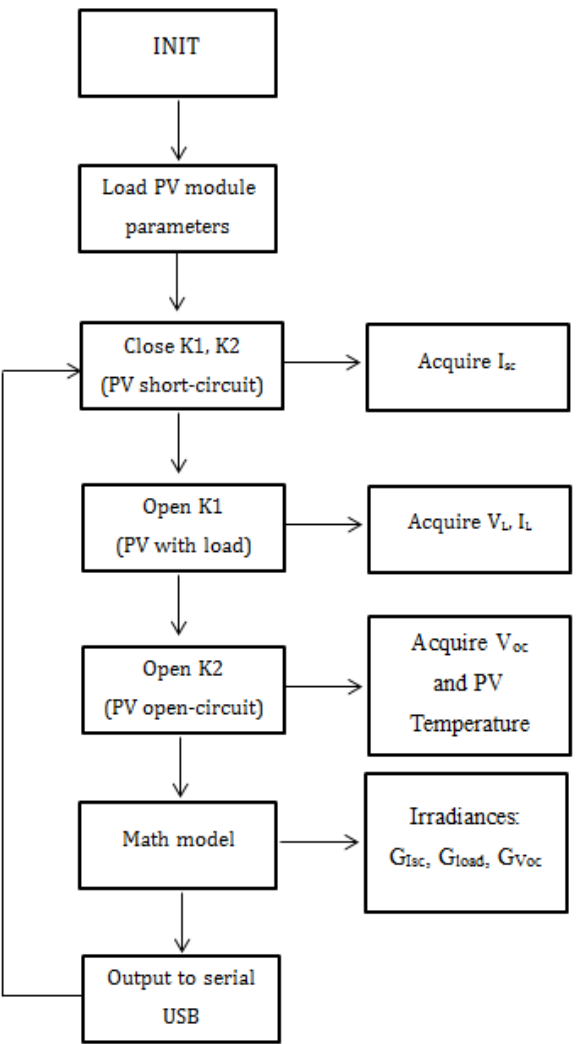
Figure 4. Flow-chart of IrradEst